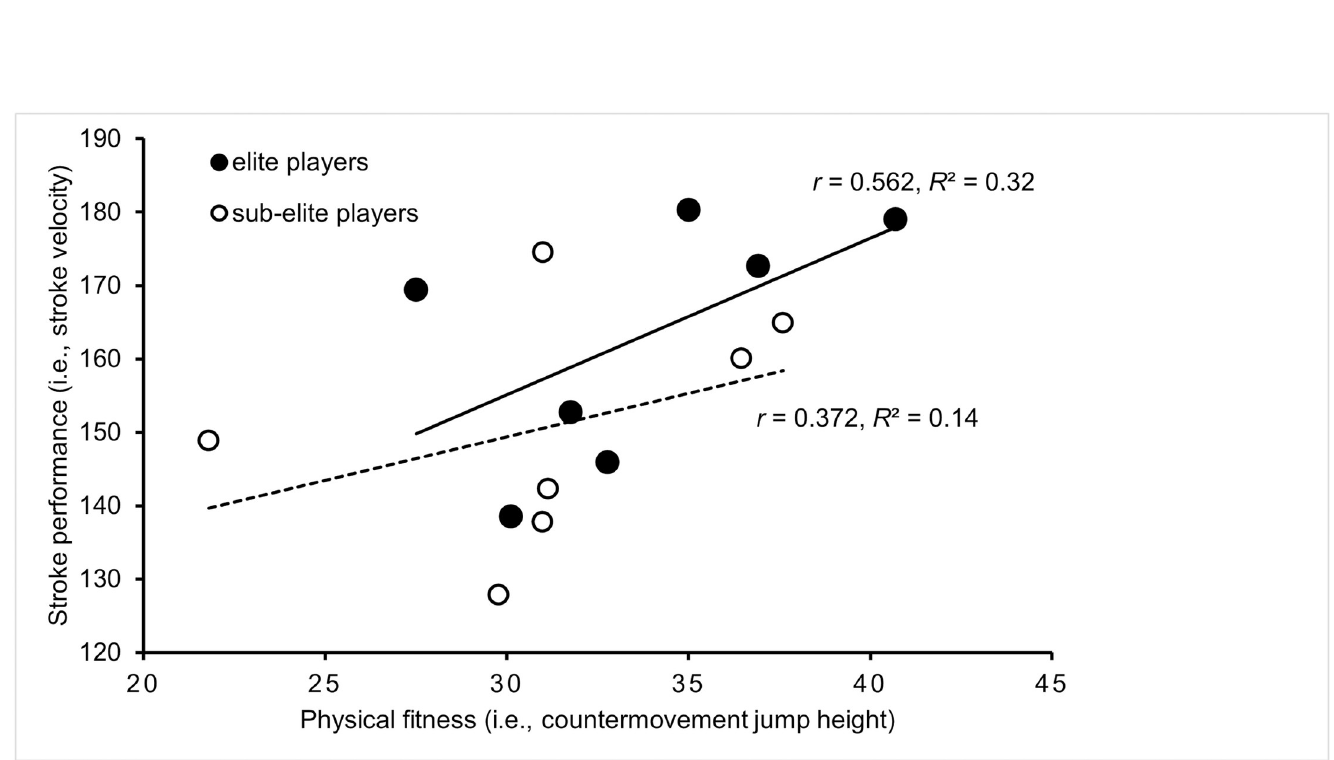
Fig 6. Differences in measures of stroke performance (i.e., stroke velocity) by competition level (i.e., elite vs. sub-elite tennis players). CI = confidence interval, df = degrees of freedom, SE = standard error, IV = inverse variance.